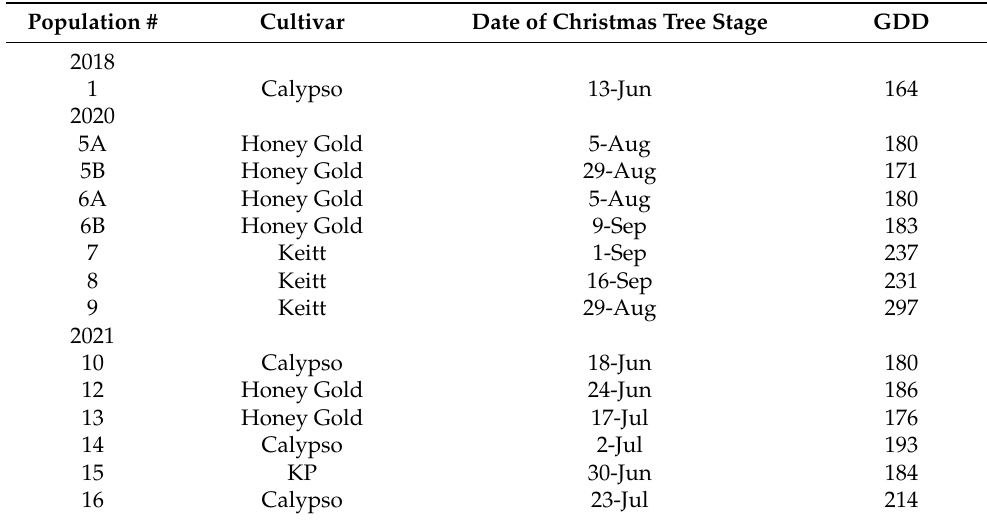
Table 6. GDD (Tb 12 ◦ C, TB 32 ◦ C) between asparagus and Christmas tree stages ( n = 15), with average and SD for each cultivar. Population numbers refer to Table